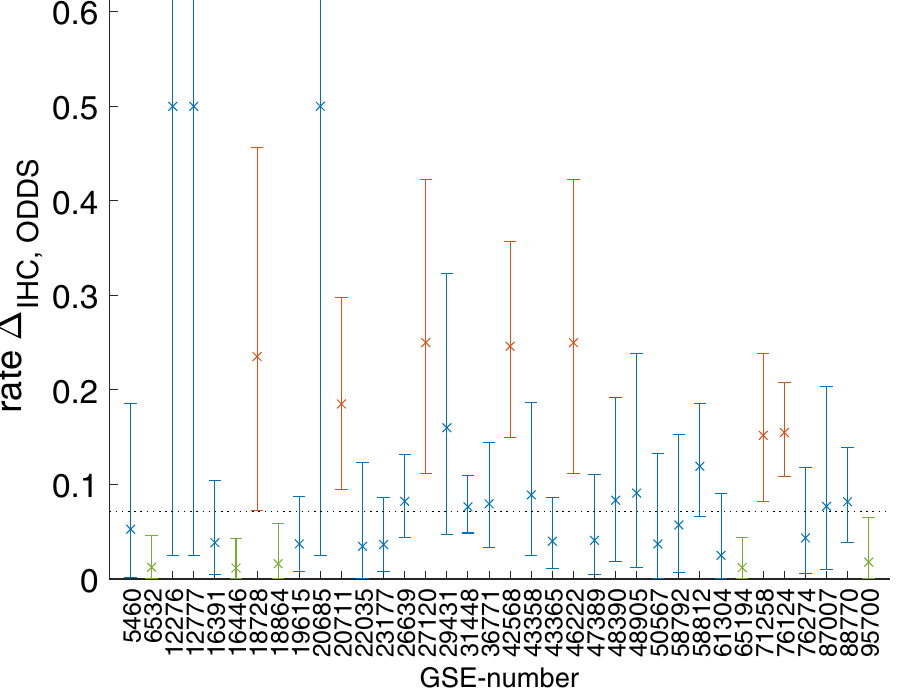
Figure 3. Control chart for estrogen receptor status: differences between IHC and ODDS gene expression estimates. x-axis: label of study. y-axis: rate of difference. Dotted line: overall mean rate of differences between IHC and ODDS p = 159/2227 = 0.071, see SuppTable 2. Markers (x) within error bars: rate of discordant samples in respective study. Lower and upper bounds of error bars denote 95% confidence limits. If the upper bound lies below the dotted line, the respective study has a discrepancy rate significantly below average (green). If the lower bound lies above the dotted line, the respective study has a discrepancy rate significantly above average (red).